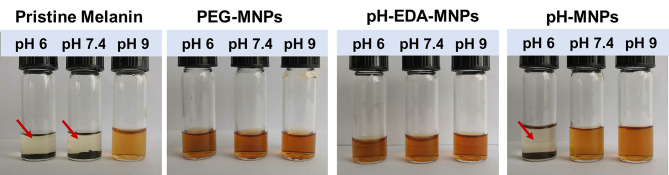
Stability of pristine melanin, PEG-MNPs, PEG-EDA-MNPs, and pH-MNPs under different pH conditions. Standing ~12 h, photos taken of all samples. The red arrow indicates precipitation at the bottom of the bottle.